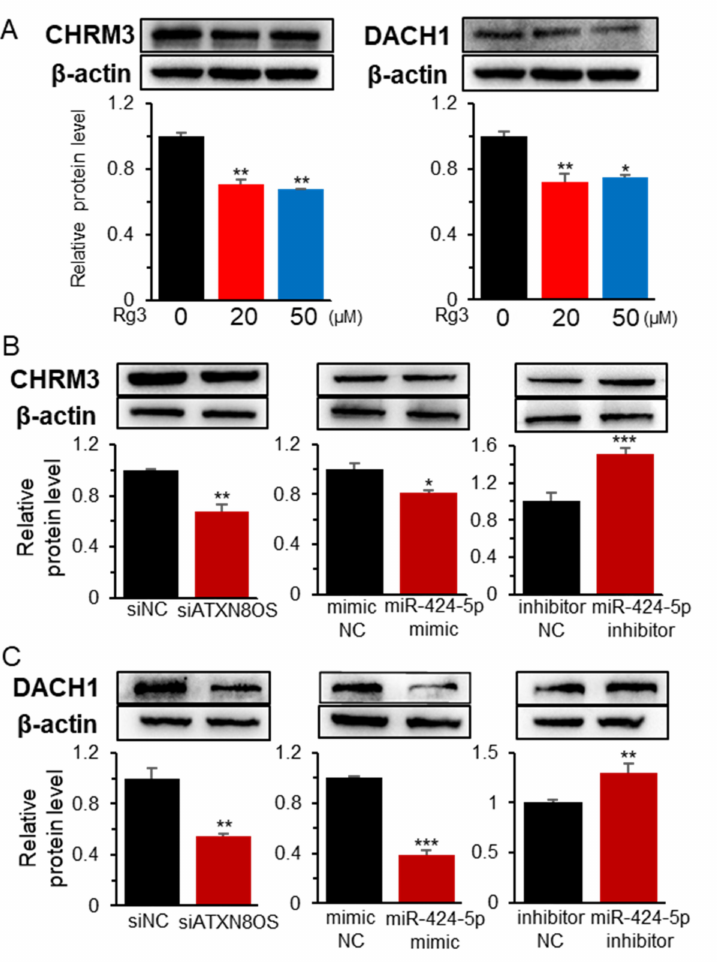
Figure 5. Effect of Rg3, ATXN8OS, and miR-424-5p on the target genes of miR-424-5p at the protein level. Western blot analysis of CHRM3 and DACH1 was performed after treating the MCF-7 cells with Rg3 ( A ) or deregulating ATXN8OS (40 µ M siRNA) and miR-424-5p (40 µ M for mimic and inhibitor) ( B , C ). Testing was done using siNC, control siRNA (40 µ M); mimic NC, negative control mimic for miR-424-5p (40 µ M); and inhibitor NC, negative control inhibitor for miR-424-5p (20 µ M). The band intensity was measured with the Image Lab software and indicated by bar graphs. * p < 0.05, ** p < 0.01, *** p <